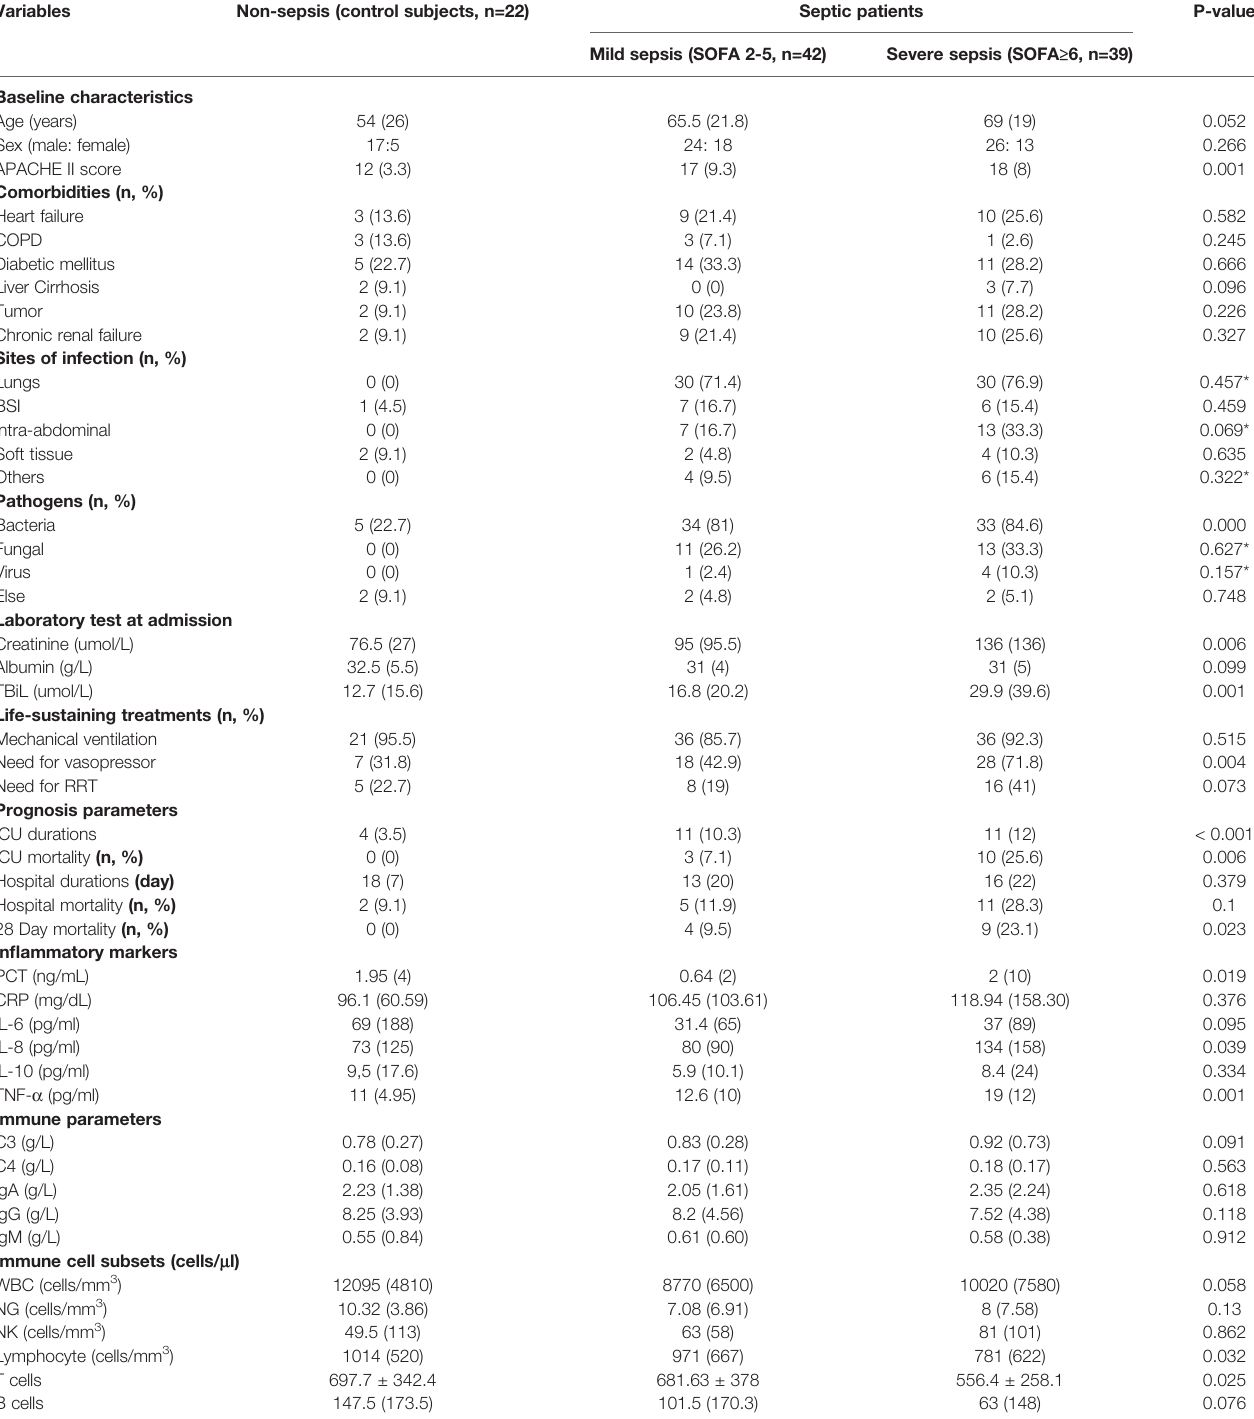
TABLE 1 | Characteristics of patients at ICU